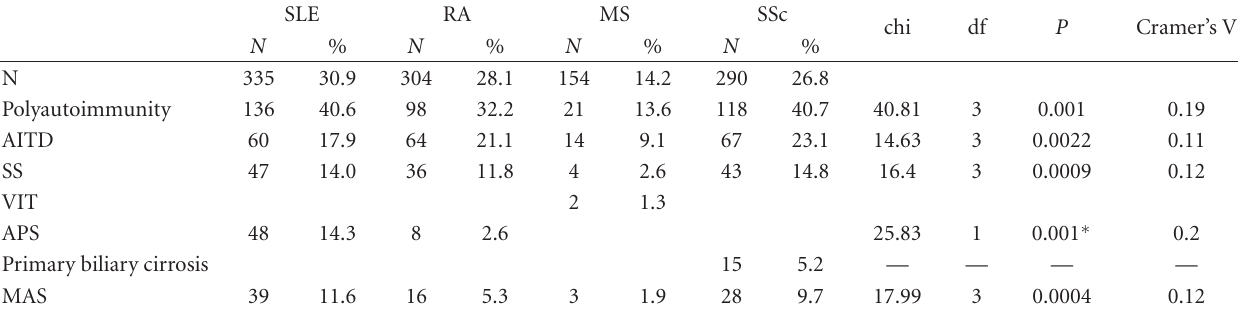
Table 1: Polyautoimmunity in 1,083 patients with four index autoimmune diseases.